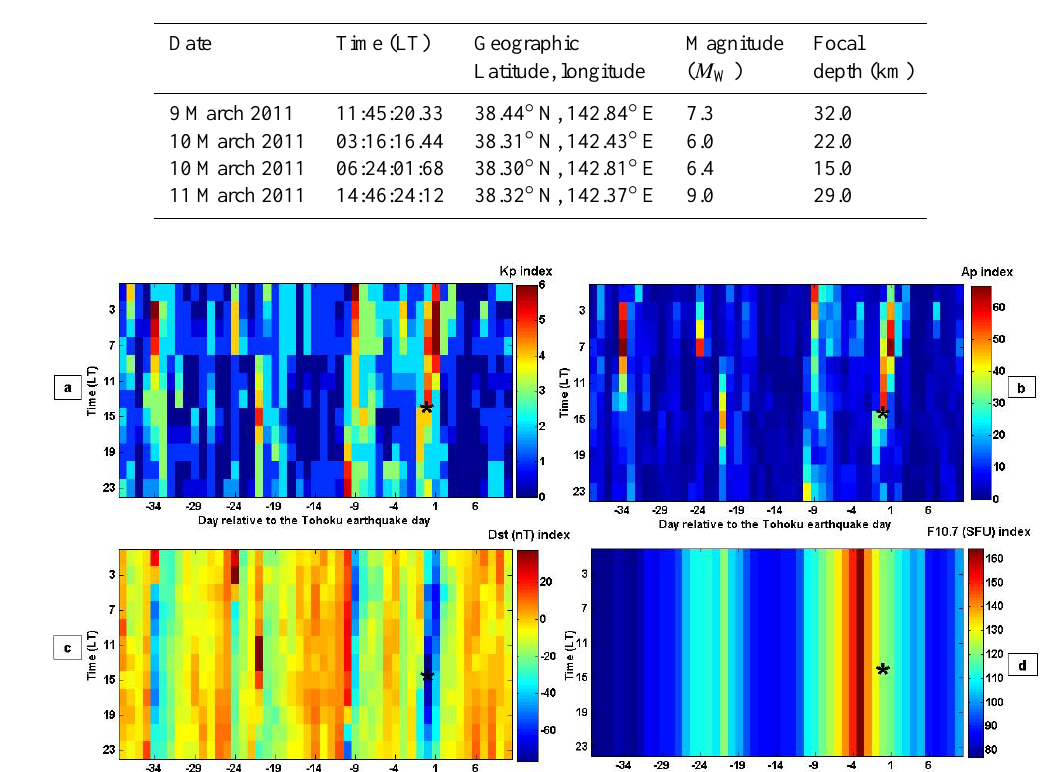
Table 1. Characteristics of the Tohoku earthquake and its main foreshocks (reported by http://earthquake.usgs.gov/).